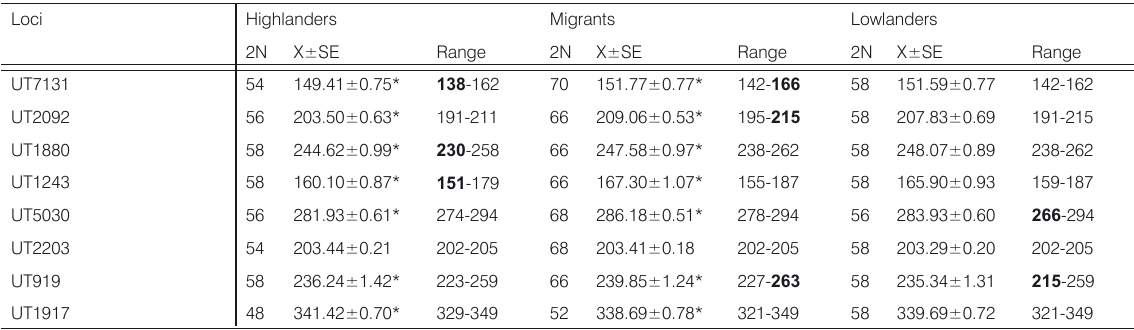
Table 3. The average alleles’ size ± SE and alleles’ sizes ranges in highland and migrant parts of split isolate in comparison with lowlanders.